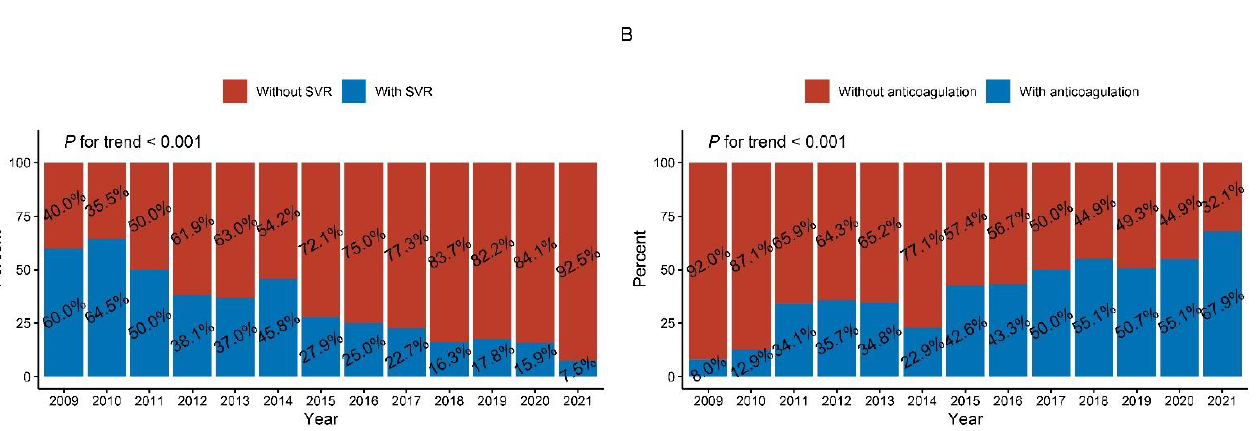
Figure 2. Time trends of therapy among patients with LVT and LVA from 2009 to 2021: ( A ) SVR; ( B ) anticoagulation therapy. LVT = left ventricular thrombus. LVA = left ventricular aneurysm. SVR = surgical ventricular reconstruction.